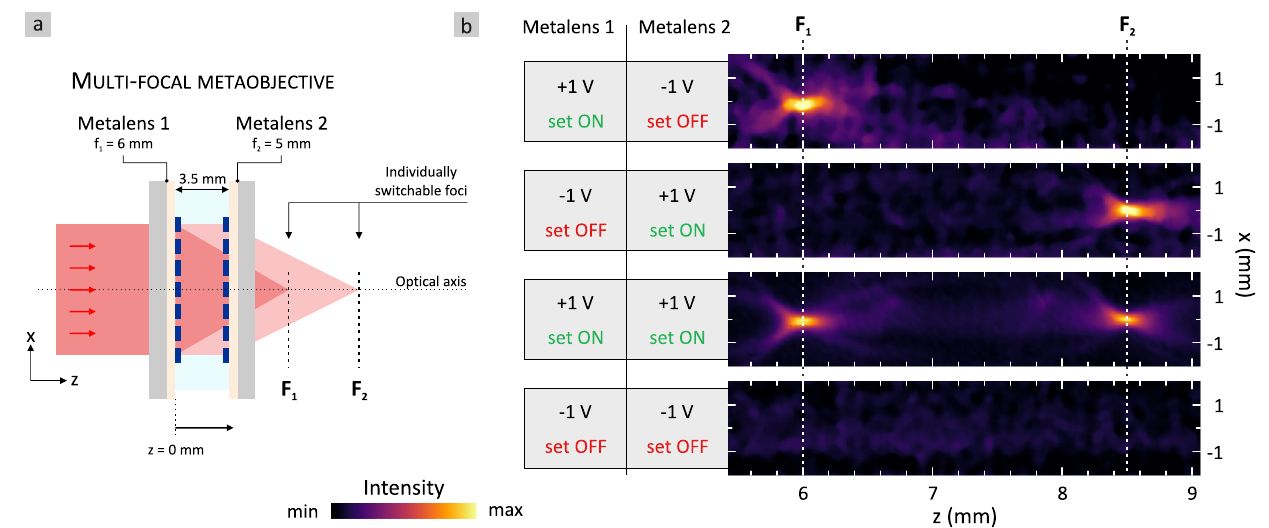
Fig. 4 | Non-volatile electrically switchable multi-functional metaobjective. a Schematic drawing of the arrangement of the metaobjective. It comprises two polymer metalenses spaced with an electrolyte. Both are electrically switchable separately via an applied voltage. The metaobjective is illuminated with an IR laser beam( λ =2.65 µ m)andthefocusedintensityisimagedalongtheopticalaxis. b The metaobjective from metallic polymer allows for four different states. Non-volatile operationisusedtosettherefractivepoweroftheindividualmetalenseseitherON